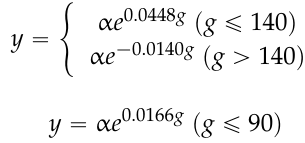
Table 4 provides the following